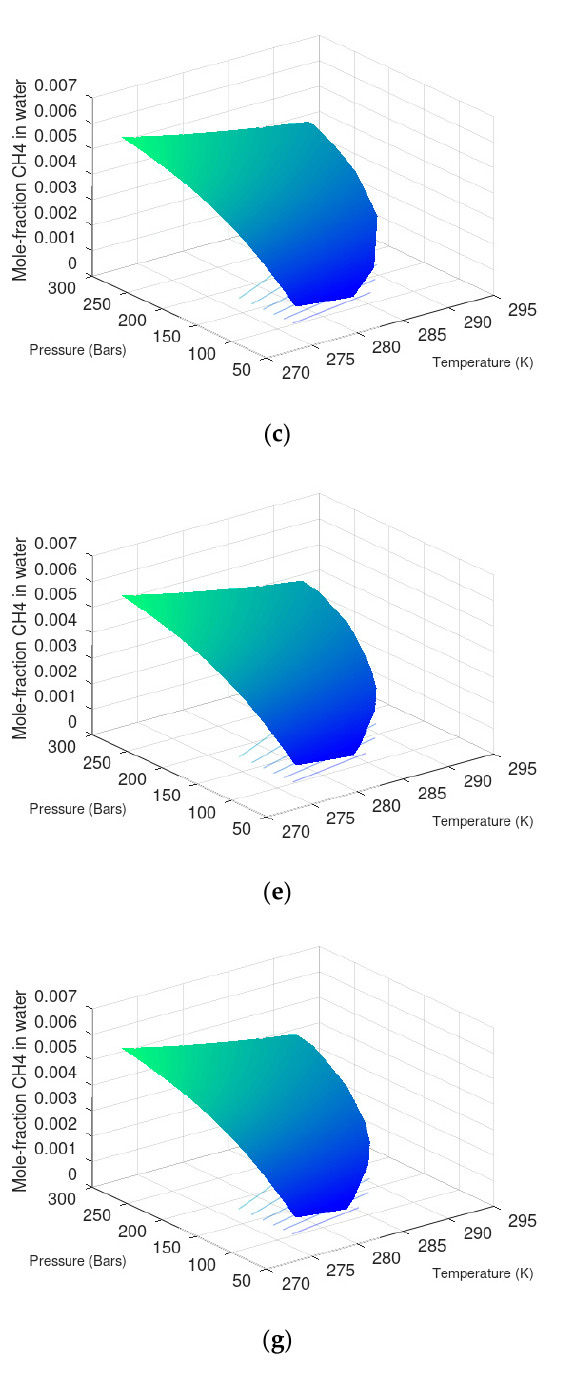
Figure 9. Liquid water solubility and hydrate stability limit mole-fractions of hydrate for various mole-fractions of ethanol. ( a ) Solubility for 0 ethanol, ( b ) hydrate stability limit for 0 ethanol, ( c ) solubility for 0.015 mole-fraction ethanol in water, ( d ) hydrate stability limit for 0.015 mole-fraction ethanol in water, ( e ) solubility for 0.02 mole-fraction ethanol in water, ( f ) hydrate stability limit for 0.02 mole-fraction ethanol in water, ( g ) solubility for 0.03 mole-fraction ethanol in water, and ( h ) hydrate stability limit for 0.03 mole-fraction ethanol in